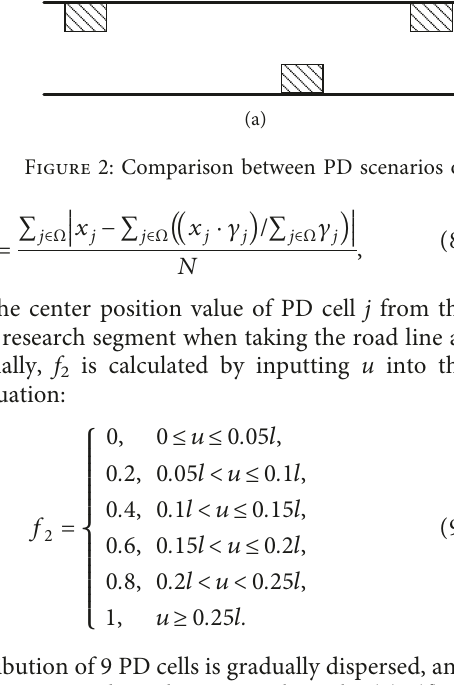
1 is small; (b) f 1 is